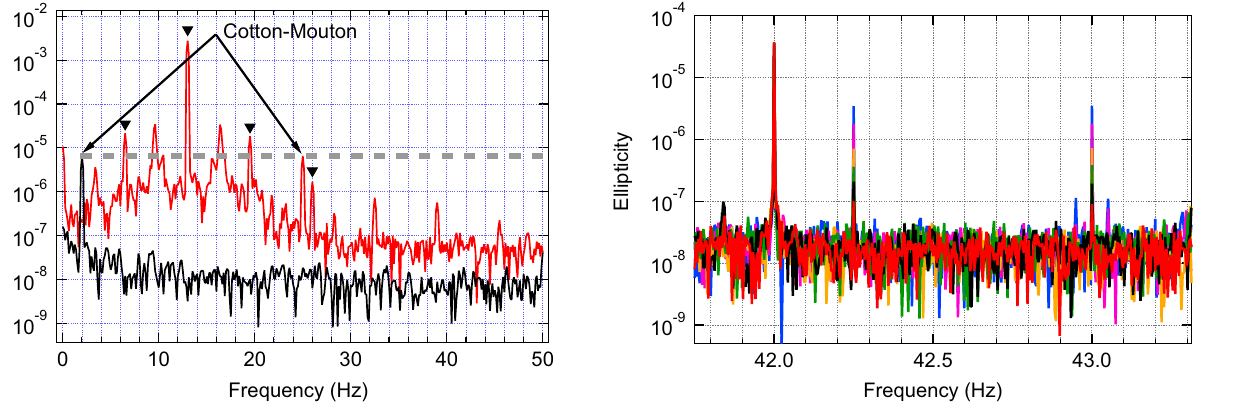
Fig. 10 Cotton–Mouton ellipticity spectra of air at atmospheric pres- sure. The two spectra have been recorded with one dipole magnet rotat- ing. For the red spectrum the wave plates also rotate at ν P = 6 . 5 Hz. The black triangles mark the first four harmonics of this frequency. A Hanning window and 10 vector averages lasting 8 s each have been used; effective time due to the windowing is 5.3 s/average